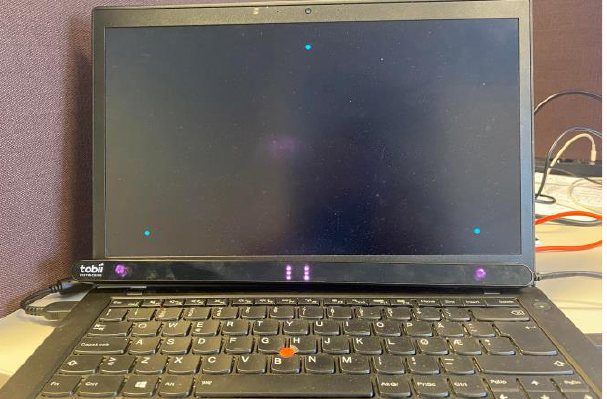
Figure 6. Eye-tracker placement and calibration window. Calibration software shows six points in two parts.